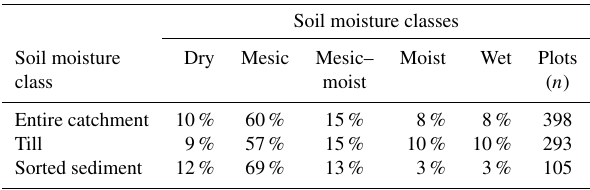
Table 2. Percentage of observations in the five soil moisture classes for the entire Krycklan catchment and divided into till and sorted sediment